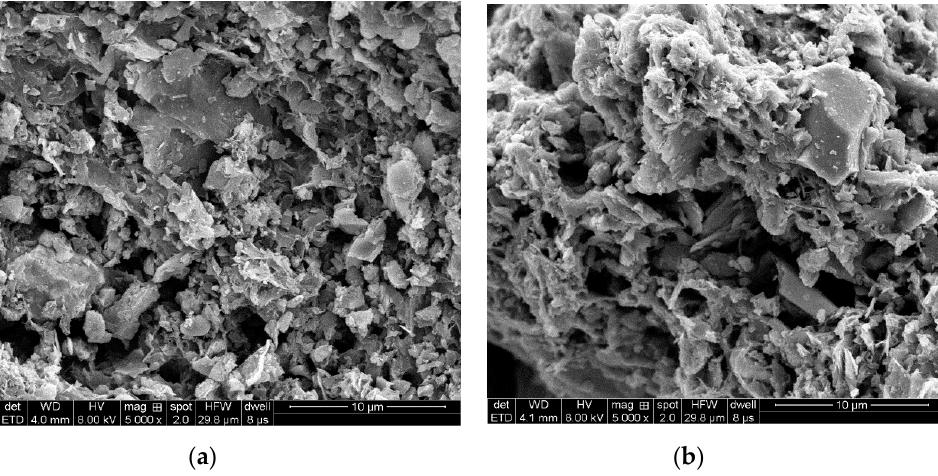
Figure 4. X-ray photoelectron spectroscopy (XPS) spectra of F-SAC and P-SAC. ( a ) F-SAC C1s; ( b ) F- SAC O1s; ( c ) P-SAC C1s; ( d ) P-SAC O1s.